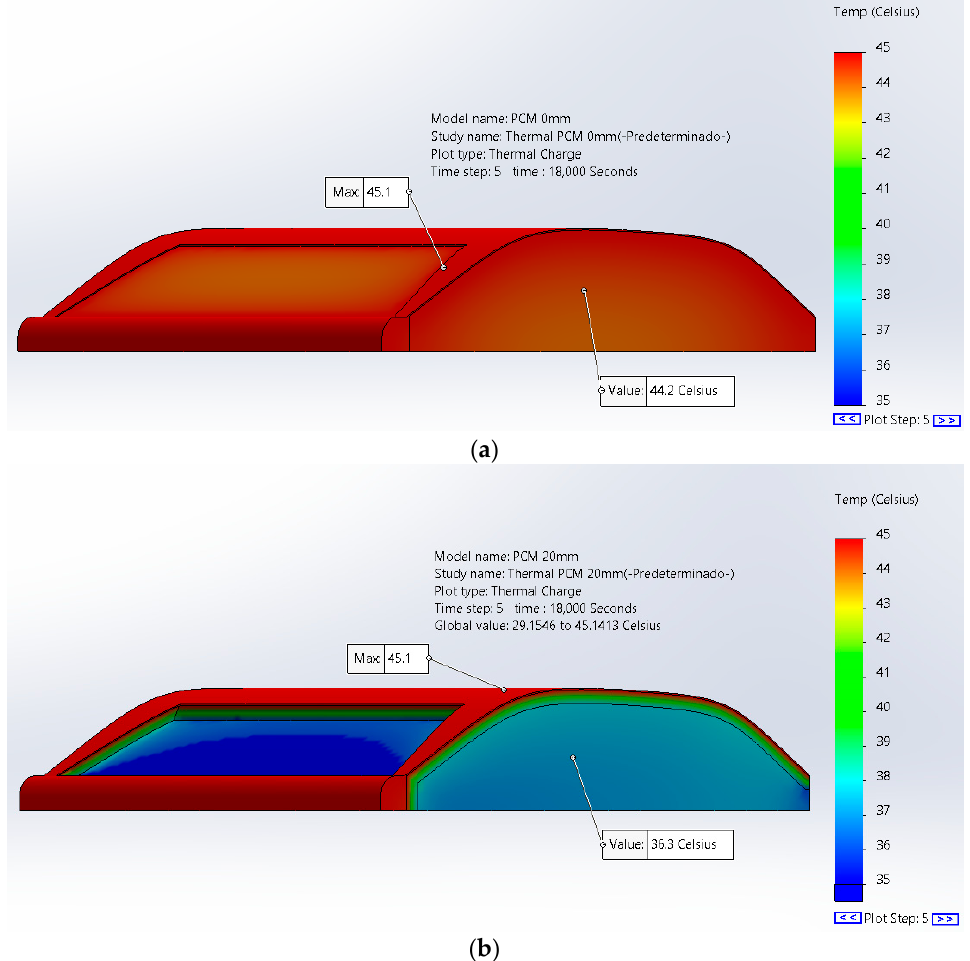
Figure 2. Charging the simulation comparison. ( a ) PCM 0 mm ( b ) PCM 20 mm